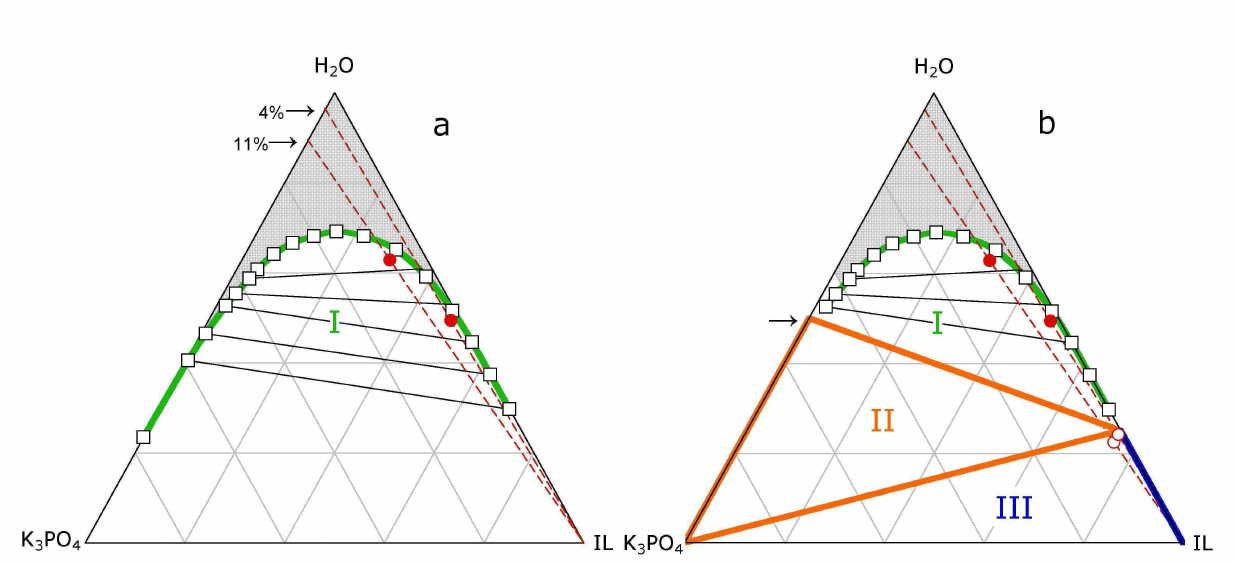
PO + [ C mim ]Cl + H O) at 298 K and a nominal pressure of 0.1 Figure 3. Ternary diagrams of (K 3 4 4 2 MPa. (a) comparison of our data (red circles) with those of Rogers and co-workers (empty squares) [1] in the ABS region (I); (b) depiction of the three-phase (II) and solid-liquid (III) regions where K PO 3 4 precipitation occurs. The arrow in (b) marks the solubility limit of K PO in water; the empty circles 3 4 indicate experimental points where precipitation from ABS occurred. Concentrations are in weight fraction. The shaded area represents the homogeneous one-phase